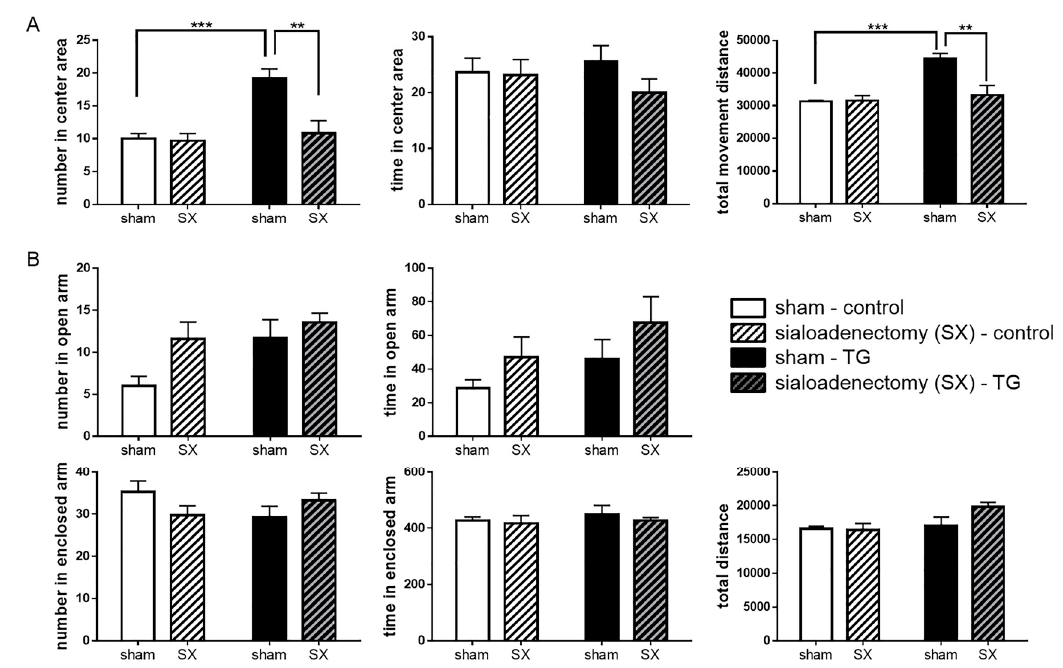
Figure 5. Behavioral effect of sialoadenectomy. ( A ) Total number of entries into the center of the open field (OF) was significantly decreased in sialoadenectomized transgenic (TG) mice. Each bar represents mean ± SEM of C57BL/6 control mice ( n = 7) or TG mice ( n = 7); ** p < 0.01, *** p < 0.001, two-way ANOVA followed by Tukey’s test; ( B ) In the elevated-plus maze (EPM), total number of entries and total time spent in the various arms were not significantly different between the two groups of sialoadenectomized mice. Each bar represents mean ± SEM of C57BL/6 control mice ( n = 7) or TG mice ( n = 7).